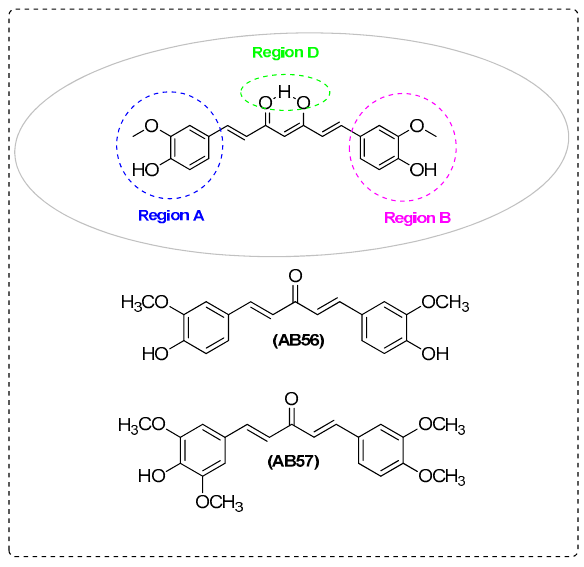
Figure 8. inhibitors. Figure 8. Anti-inflammatory